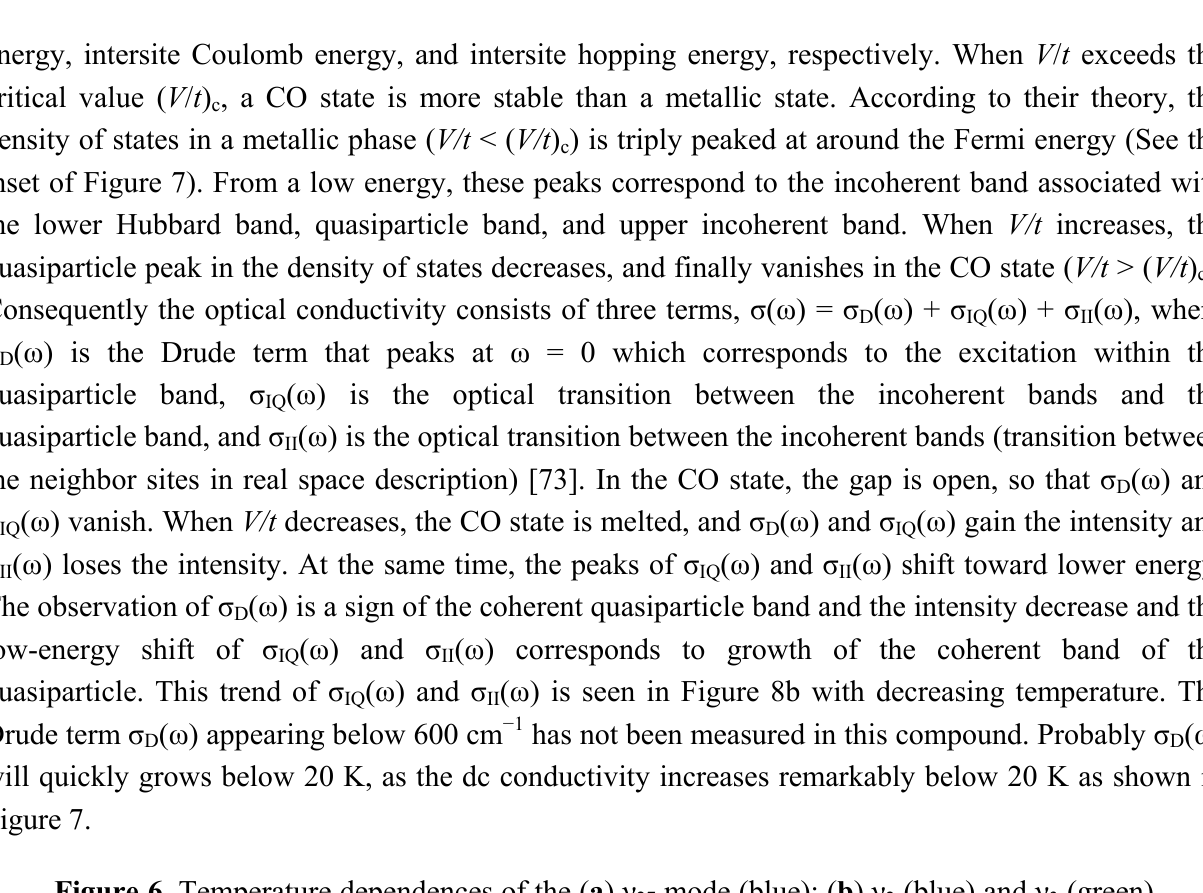
mode (blue); ( b ) ν (blue) and ν (green) 27 2 3